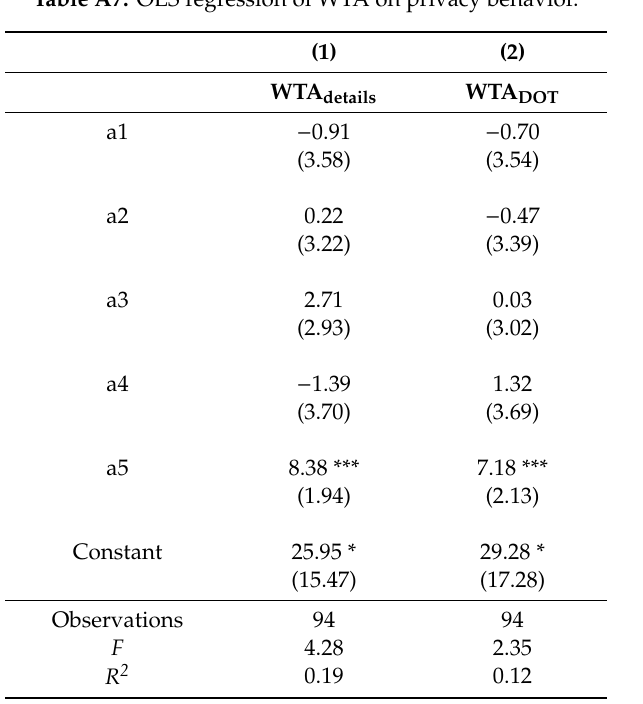
Table A7. OLS regression of WTA on privacy